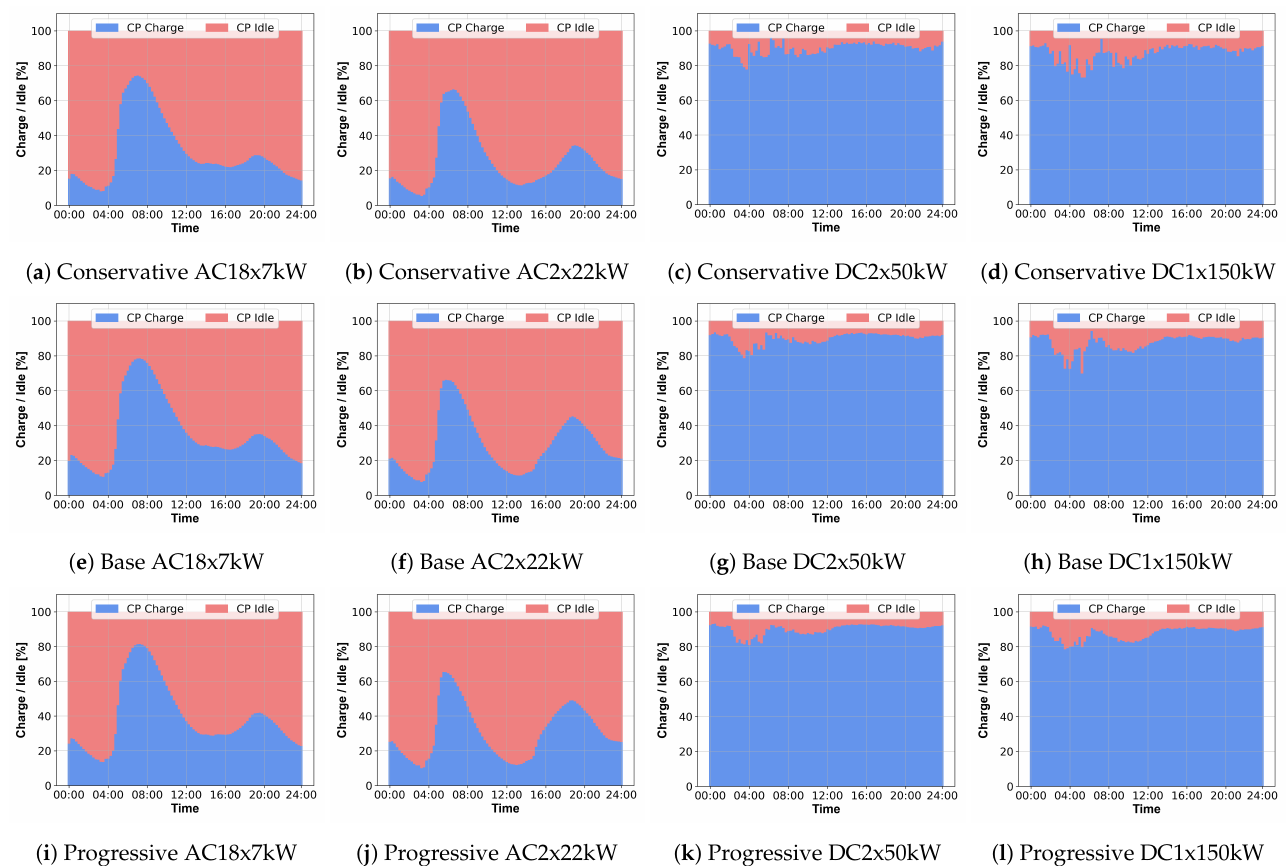
Figure 11. Charging and idle time of the charging concepts for the defined